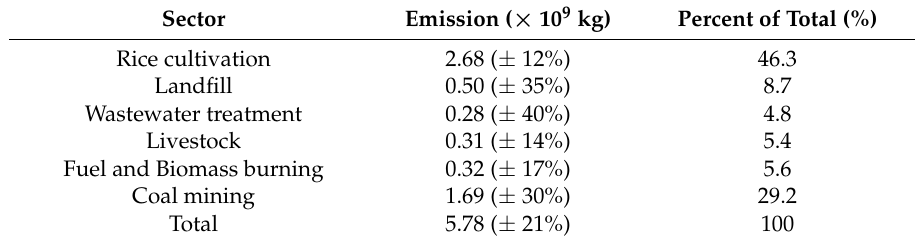
Table 2. Anthropogenic CH 4 emissions in the Yangtze River Delta in 2012, based on the IPCC inventory method.